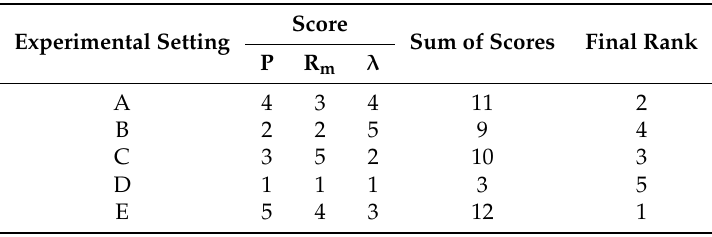
Table 5. Ranking of the various pH setting